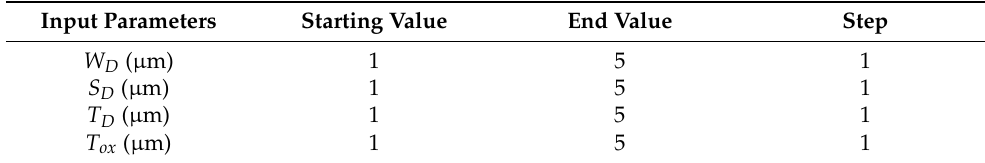
Figure 4. Parametric flat capacitance model with DMFs. Table 1. Sweep Parameters.